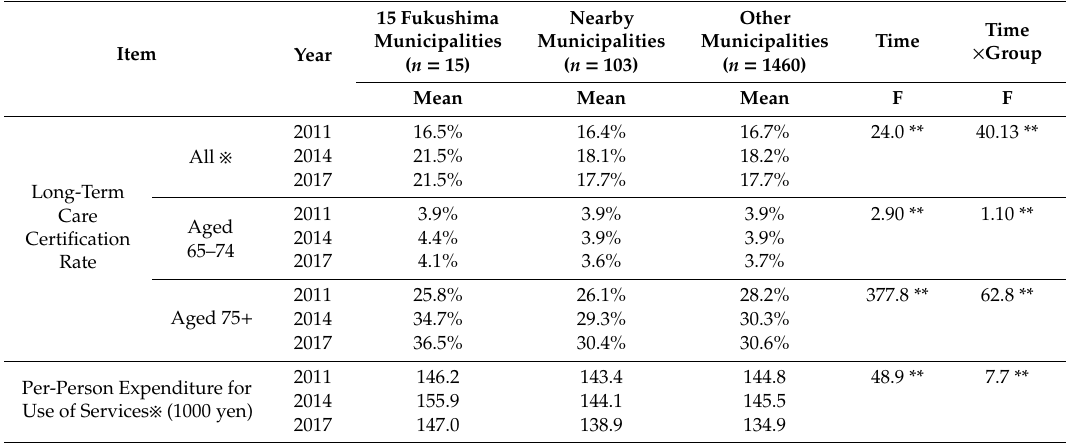
Table 2. Long-term care certification rate and per-person expenditure for use of services (analysis of